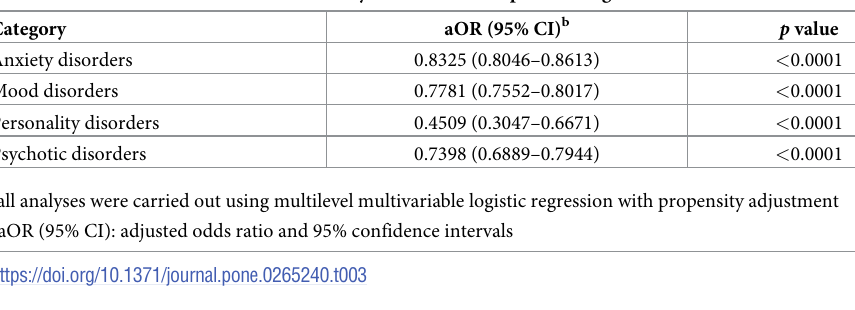
Table 3. Odds ratios for short-term mortality associated with specific categories of mental disorders a .